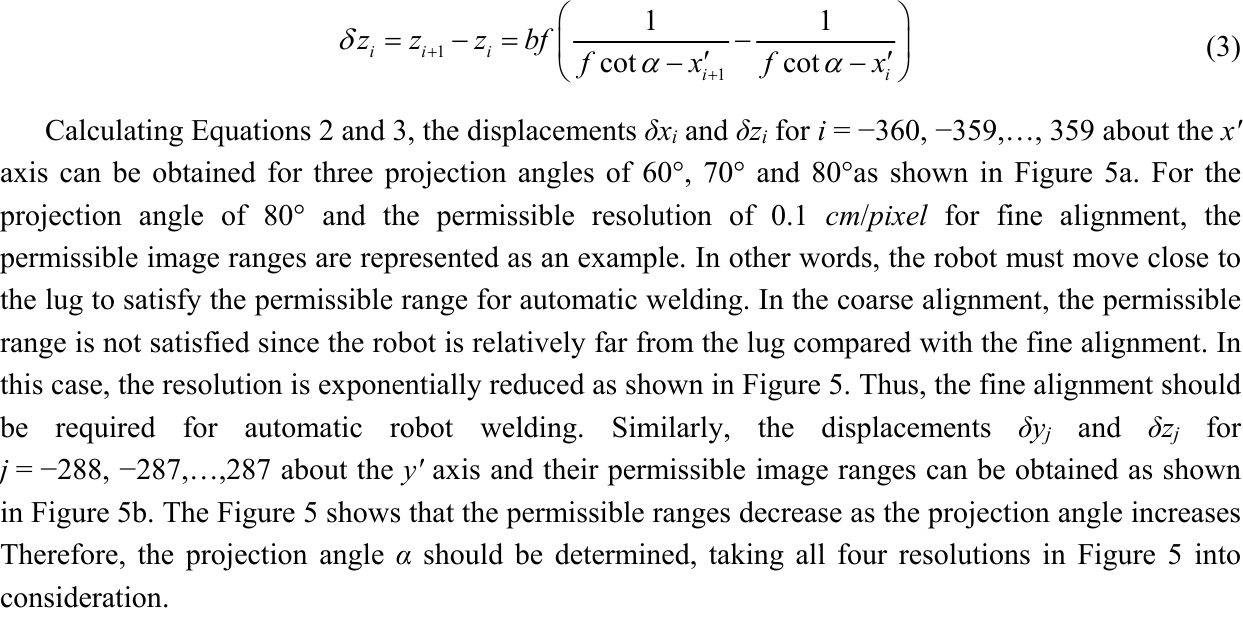
Figure 5. Permissible image ranges for the permissible resolution of 0.1 cm/pixel, where the baseline b is 7